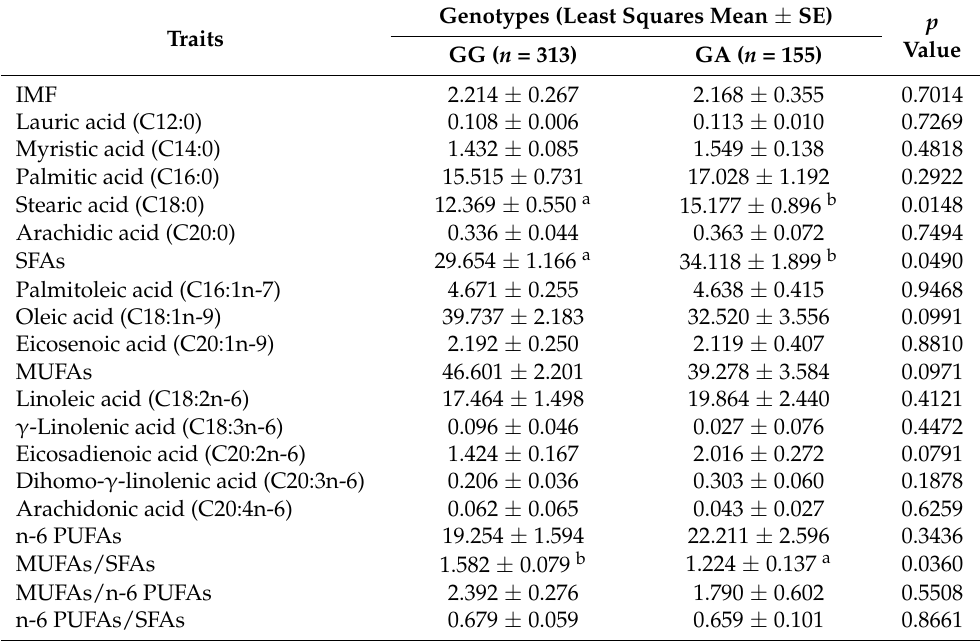
Table 3. Association of porcine IFNA16 c.413G > A gene with IMF content and FA composition traits in longissimus thoracis muscles of pigs.